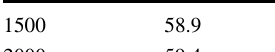
various concentrations of salts in the absence of nanoparticles and DTPMP